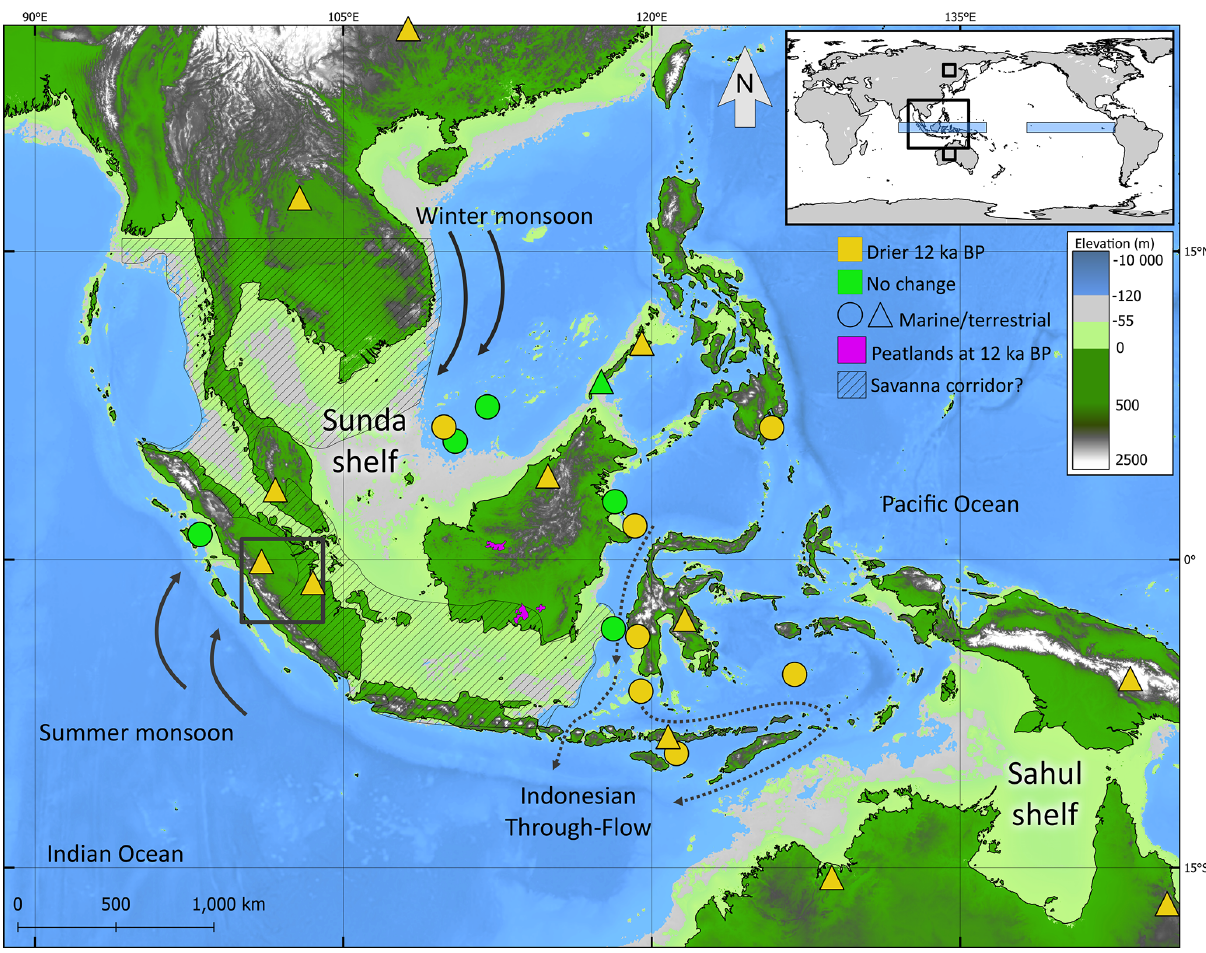
Figure 1. Topographic map of South-East Asia and a compilation of available climate proxy records (Table S1 in the Supplement). Yellow markers indicate drier or more seasonal climate at 12kaBP compared to PI, and green indicates no notable difference. Purple areas denote the peatland extent at 12kaBP (Dommain et al., 2014). Exposed land due to lower sea level at 12kaBP shown in light green and in light gray for the LGM. The hatched area indicates the proposed savanna corridor on the Sunda Shelf at the LGM (Cannon et al., 2009). The black square on the regional map indicates the area used to track long-term changes in seasonality from TRACE (Fig. 2f and g). Small black squares in the global map inset show the areas used for estimating the thermal gradient over ISEA and blue squares are used for Walker Circulation Index calculations (Fig.